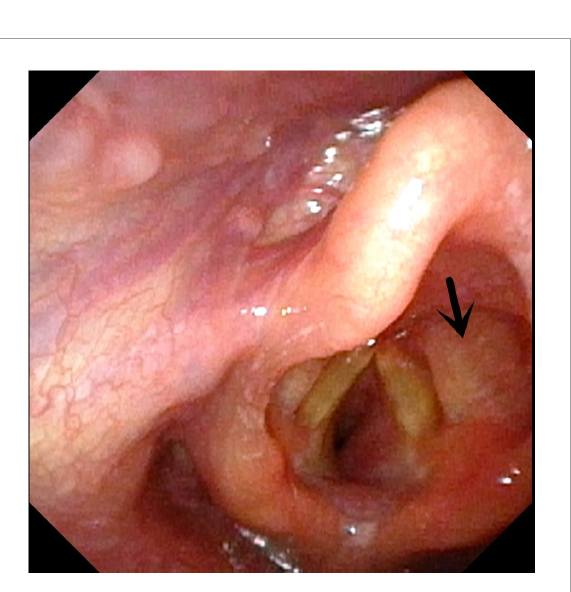
FIGURE4 Subglottic hemangioma. Arrow indicates right subglottic